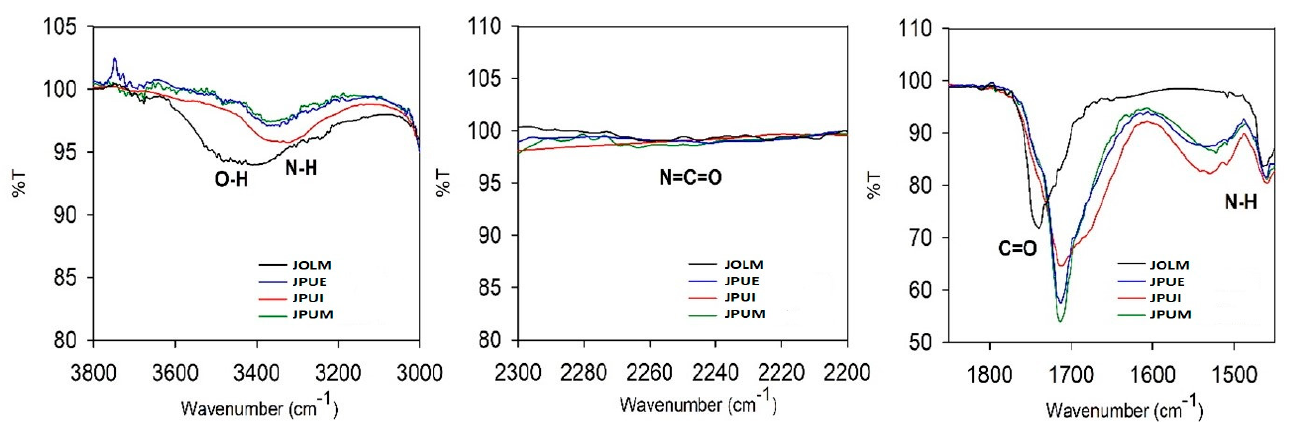
Figure 7. Essential functional groups in JPU samples.